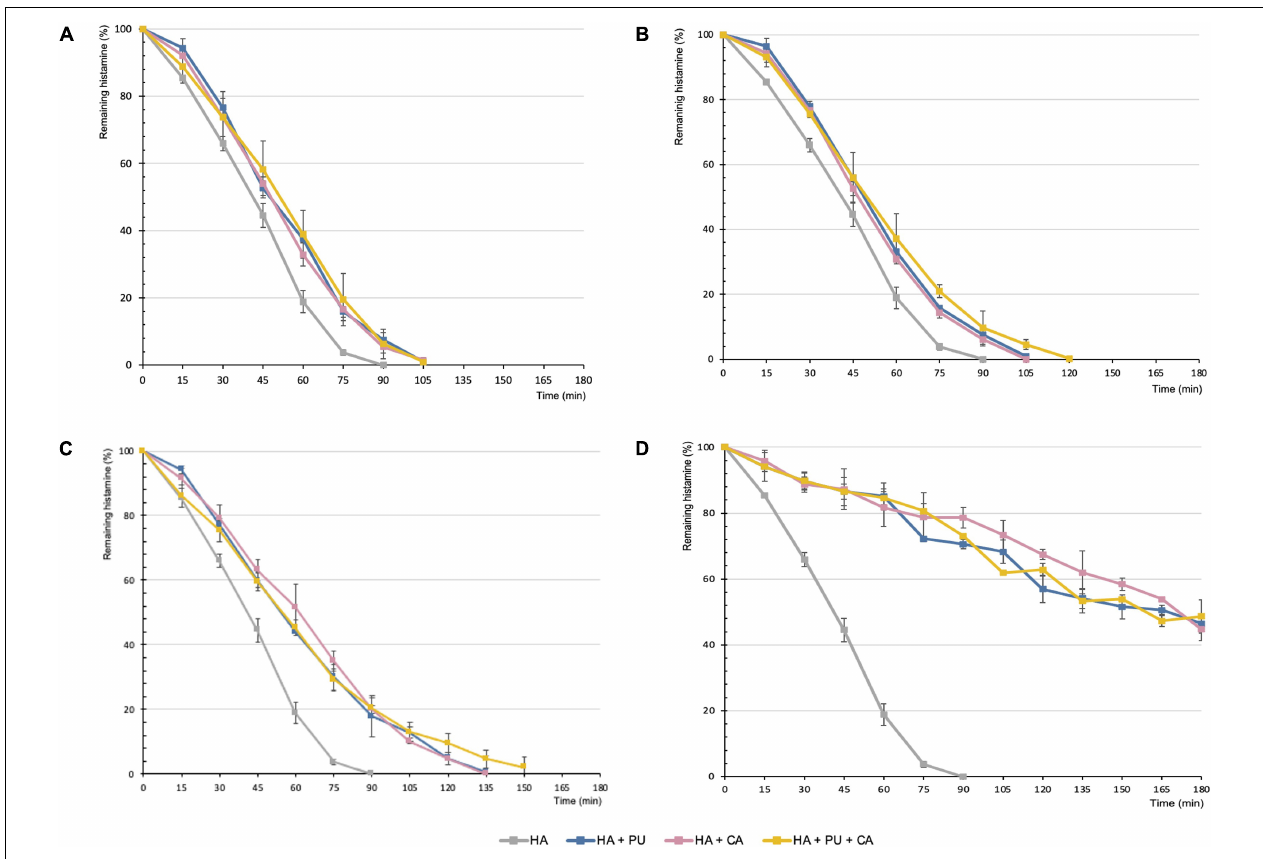
FIGURE 2 | Degradation of histamine (25 mg/L) by itself or with different amounts of putrescine, cadaverine or a mixture of both diamines (sum of equivalent amounts of putrescine and cadaverine). The resulting substrate proportions assayed were the following (histamine:amino substrate): 1:0.25 (A) , 1:1 (B) , 1:4 (C) , and 1:20 (D) . HA, Histamine; PU, Putrescine; CA,